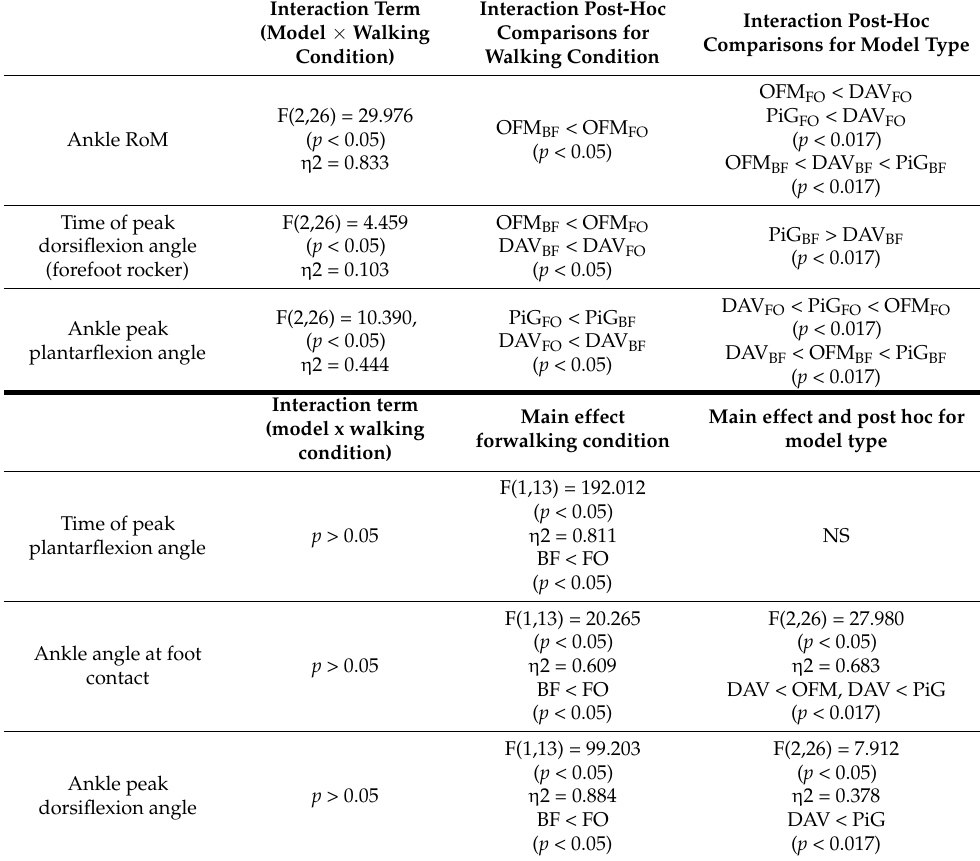
Table 1. Summary of statistical results. In the case of model × walking interaction (first part of the table), post-hoc comparisons are detailed for walking condition and model separately. When interaction was not significant (second part of the table), only main effects were reported for walking condition and model separately. RoM: range of motion; FO: foot orthosis condition; BF: barefoot condition; OFM: Oxford foot model; PiG: plug-in gait; DAV: